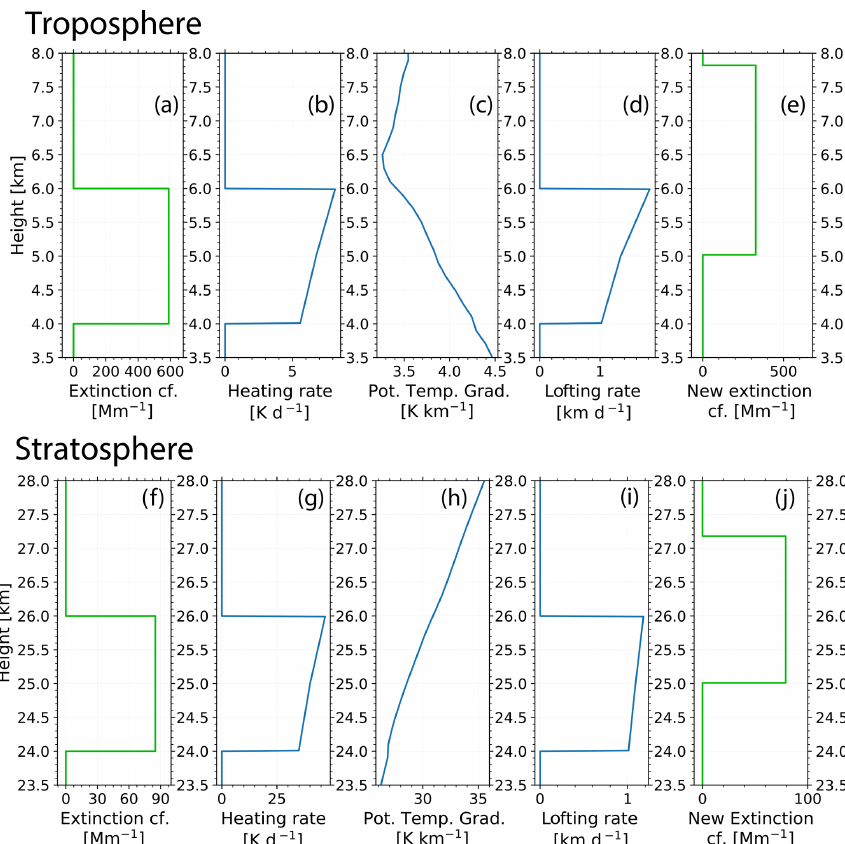
Figure 10. Self-lofting effects on layer depth in the troposphere ( a – e , layer at 4–6km height before lofting) and in the stratosphere ( f – j , layer at 24–26km height before lofting). Step-by-step calculation of the new layer profile after 1d of heating and lofting. The extinction profiles in (a) and (f) were used in the simulations, (b) and (g) show the resulting heating rate profiles, (c) and (h) show the potential temperature profiles at Punta Arenas assumed in the simulations, (d) and (i) show the resulting lofting rate profiles, and (e) and (j) show the resulting new extinction coefficient profiles in the troposphere and stratosphere after 1d of self-lofting. Extinction profiles (old and new) are highlighted in